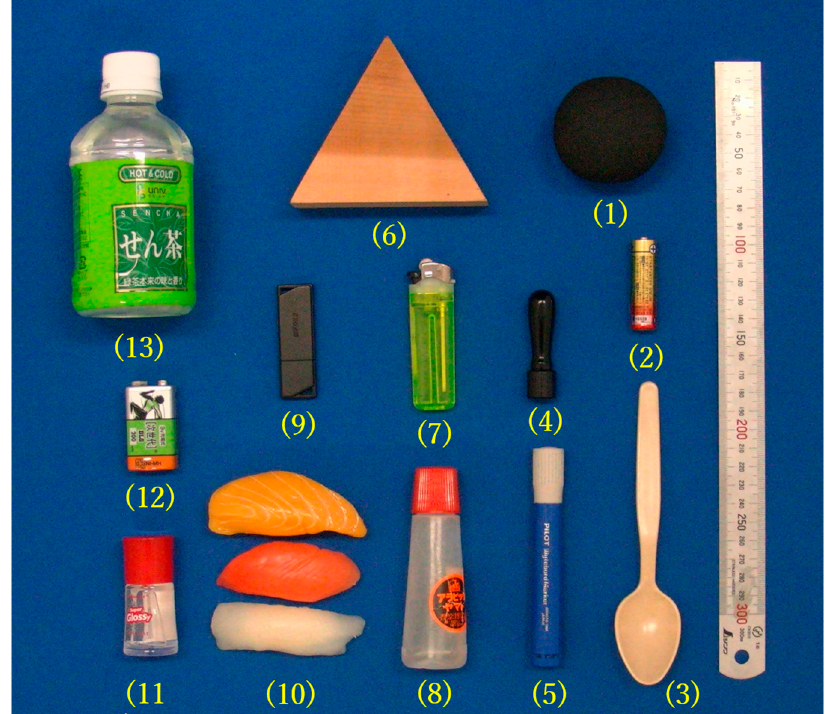
Figure 20. Objects used in pick-and-place